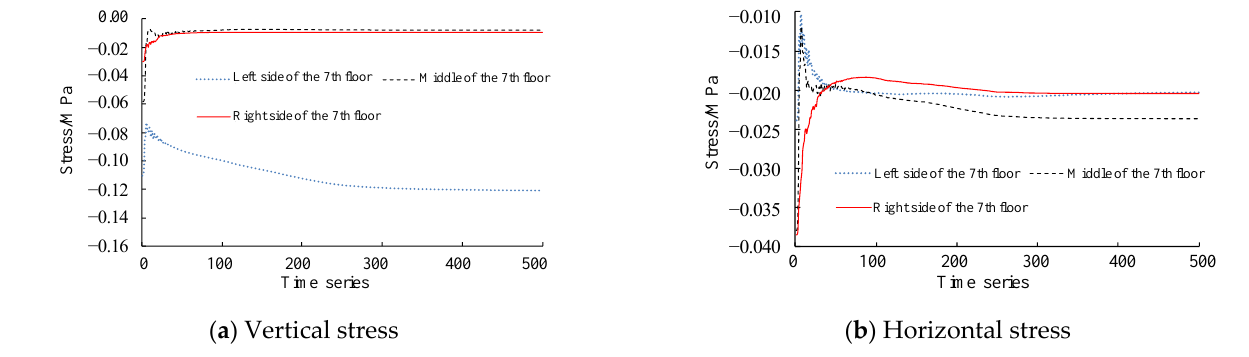
Figure 11. static load stress of bottom plate after excavation of the seventh layer.